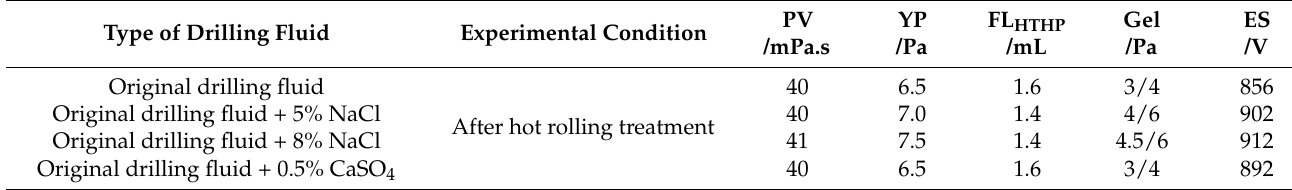
Table 5. Test results of the salt and calcium resistance of the oil-based drilling fluid.